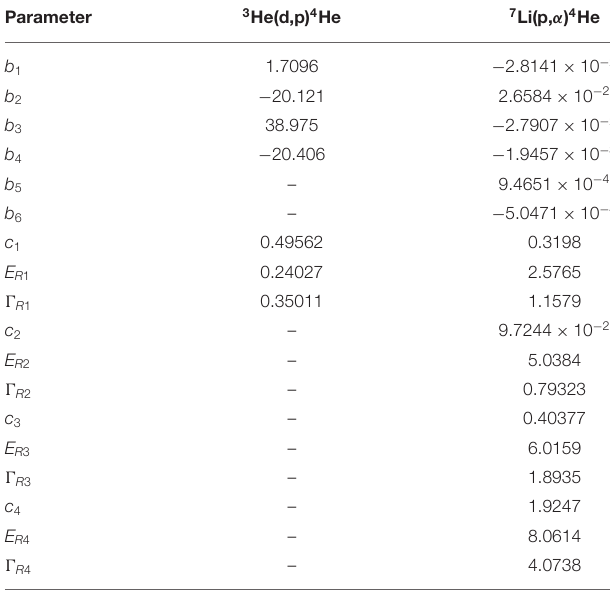
Frontiers in Astronomy and Space Sciences |